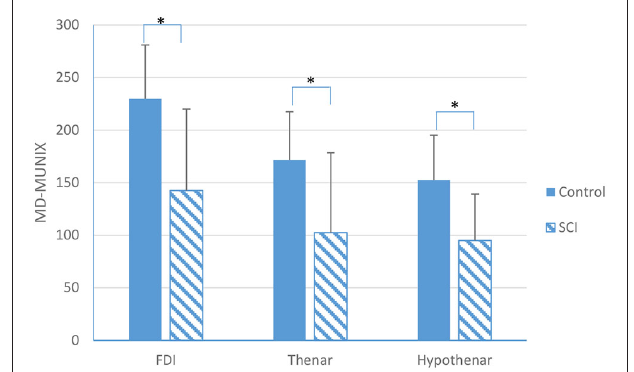
FIGURE 3 | A comparison in MD-MUNIX between SCI and neurologically intact subjects for the FDI, thenar and hypothenar muscles (mean ± standard deviation, *indicates p < 0.05) .